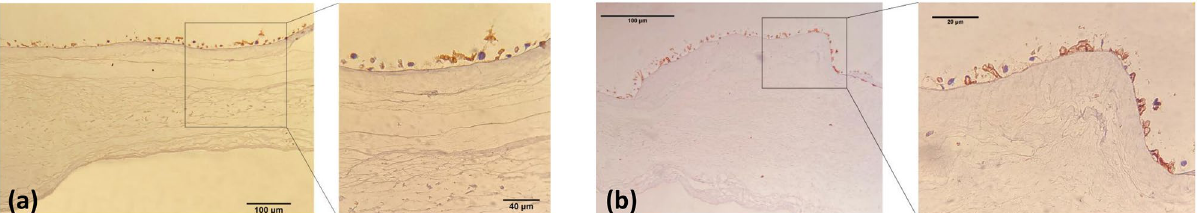
Figure 6. IHC for vWF after culturing HUVECs on both sides of dbACM; ( a ) amniotic side basement membrane of dbACM; ( b ) chorionic side basement membrane of dbACM.